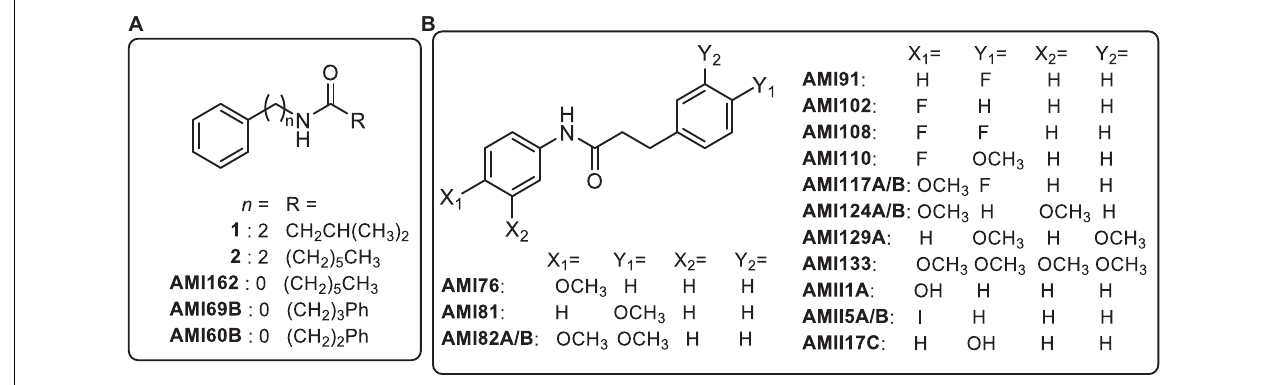
FIGURE 1 | Chemical structures of marine bacterial secondary metabolites ( 1 and 2 ) and synthetic analogs. Panel (A) analogs represent modifications to the acyl group (R), and distance of the amide bond from the phenyl group ( n ). Panel (B) analogs include substitutions on the phenyl rings (X and Y) of analog